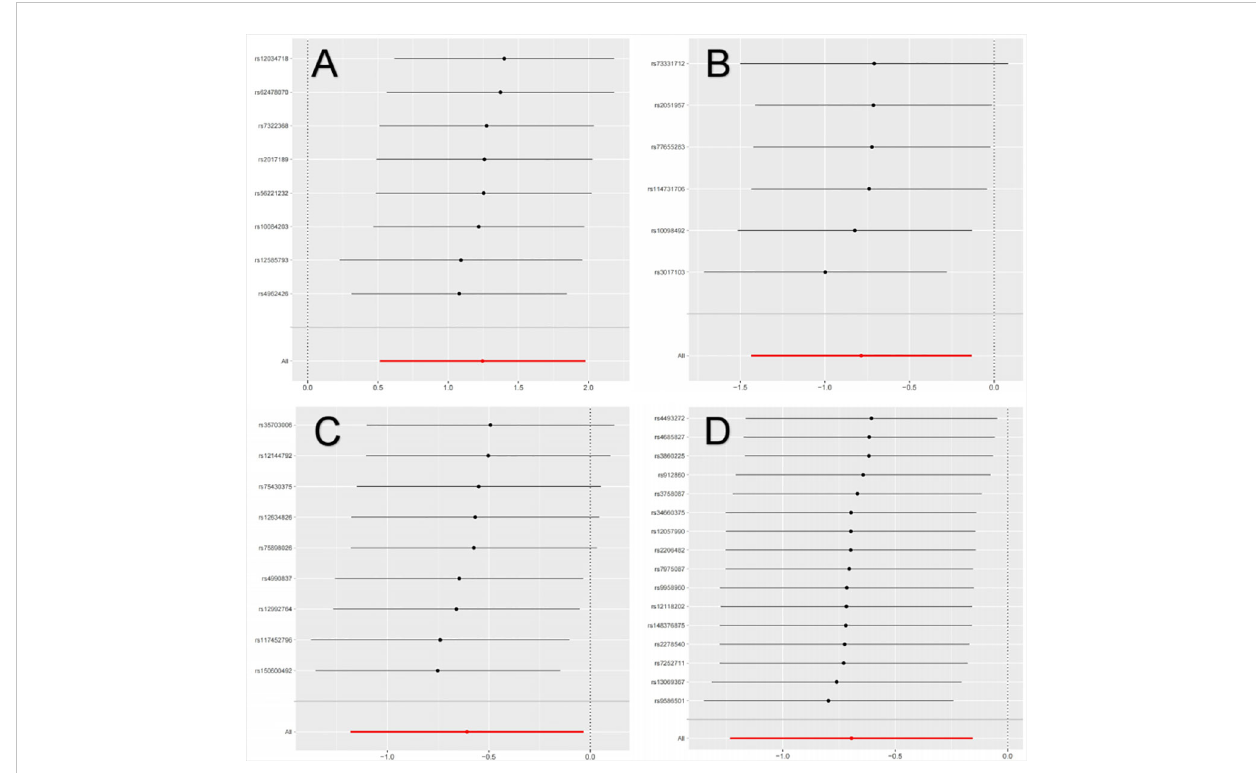
FIGURE 3 Leave-one-out analysis of the causal association between GM and IgAN. (A) Leave-one-out analysis of the causal association between Butyricicoccus and IgAN; (B) Leave-one-out analysis of the causal association between Enterorhabdus and IgAN; (C) Leave-one-out analysis of the causal association between Peptococcaceae and IgAN; (D) Leave-one-out analysis of the causal association between Prevotellaceae and